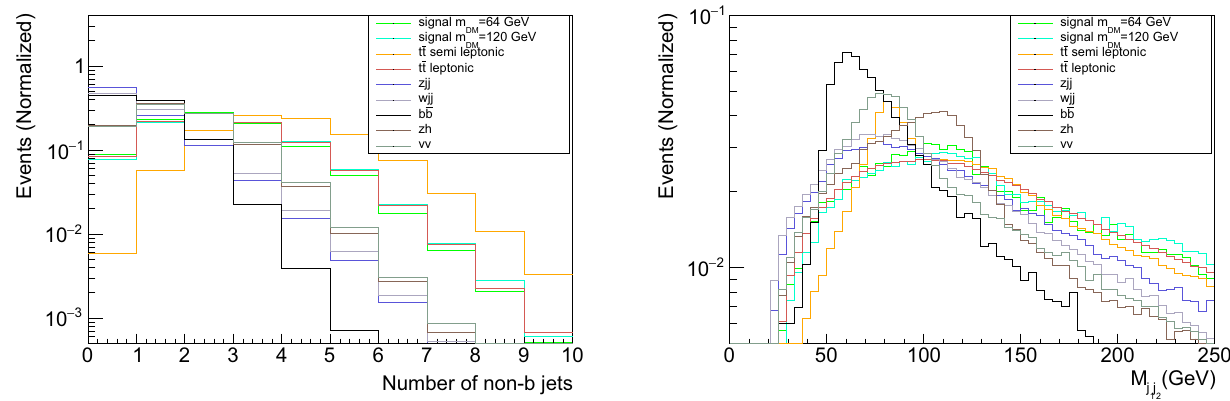
Fig. 14 Normalized distributions of jet multiplicity (left) and invariant mass of leading and sub-leading (right) light jets